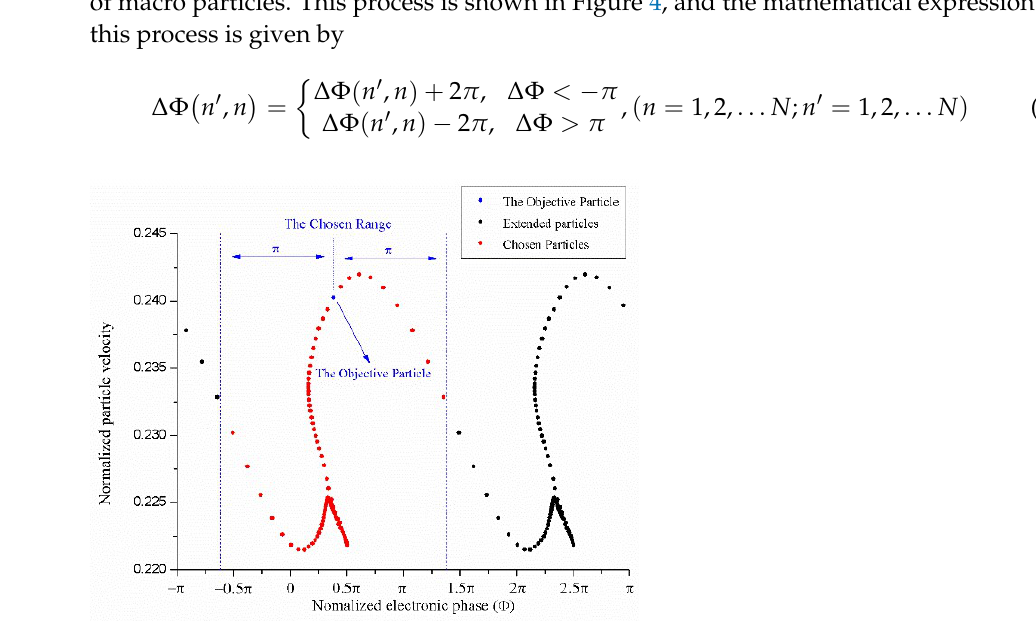
Figure 4. The source particles chosen from periodic extended particles, whose phase difference with the objective particle is at ( − π , + π ) .